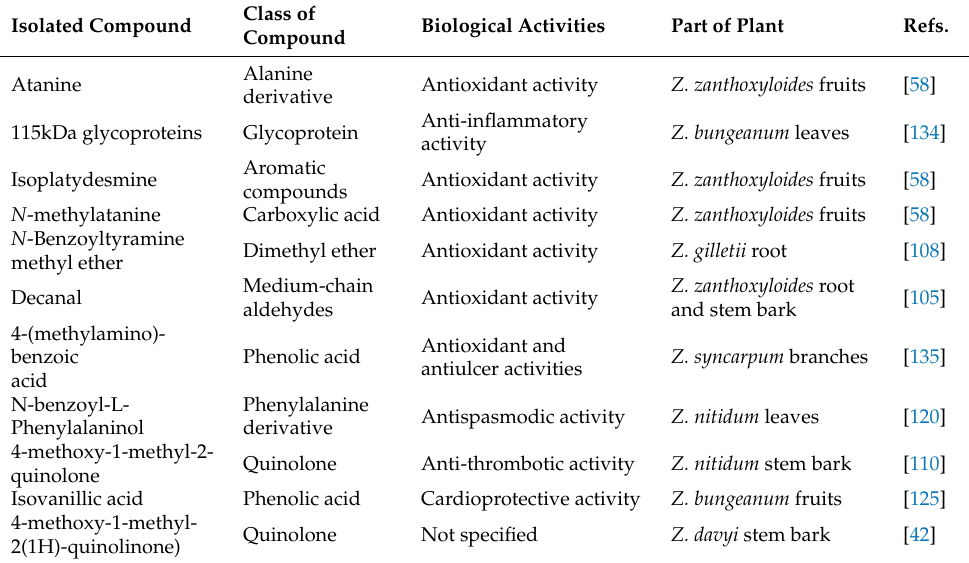
Table 9. Other chemicals isolated from Zanthoxylum species and their biological